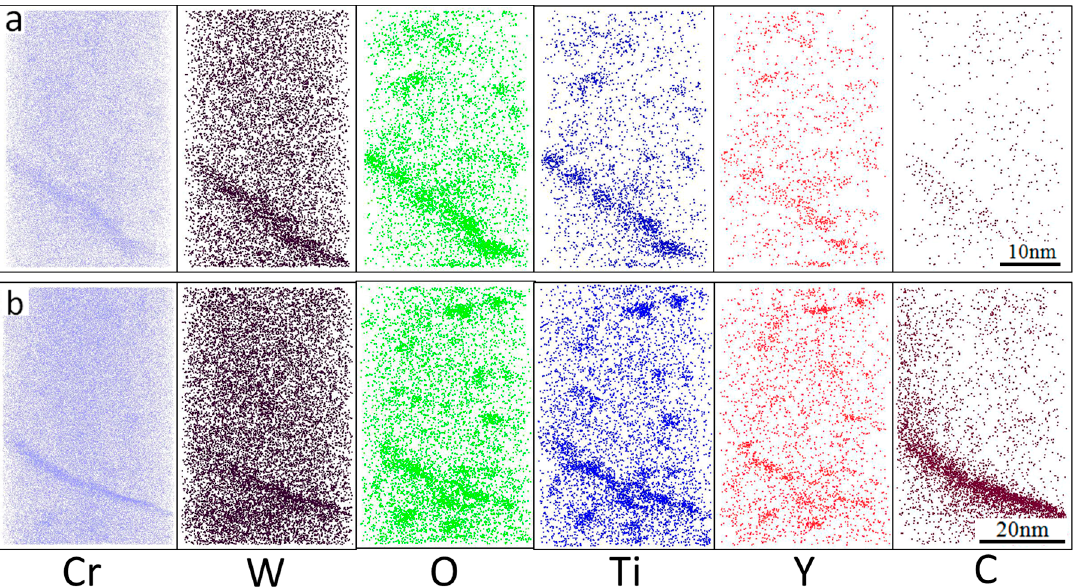
Figure 3. APT atom maps of elements in the 14YWT alloy ( a ) before heavy ion irradiation and ( b ) after heavy ion irradiation to 100 dpa at 700 °C.